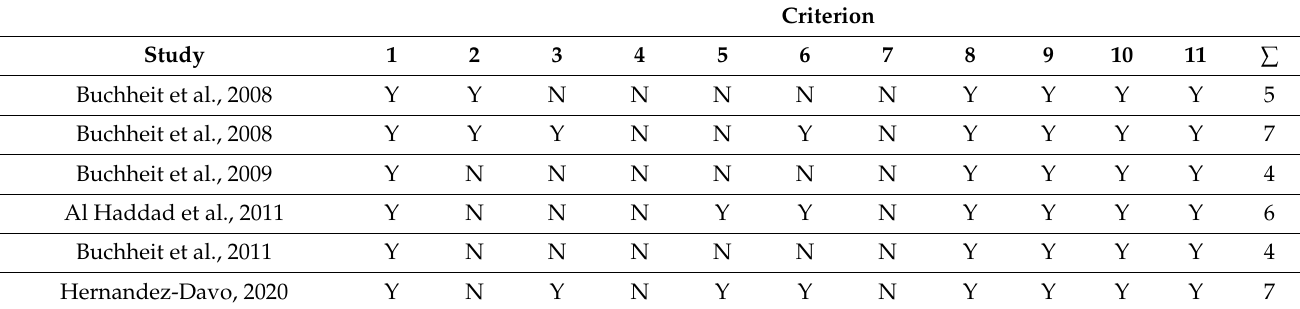
Table 2. PEDro Scale for studies where IFT 30–15 is used for training